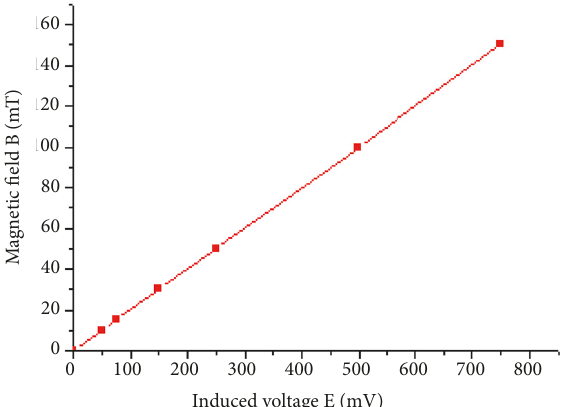
Figure 4: Effective value of magnetic field versus effective value of electromotive force.